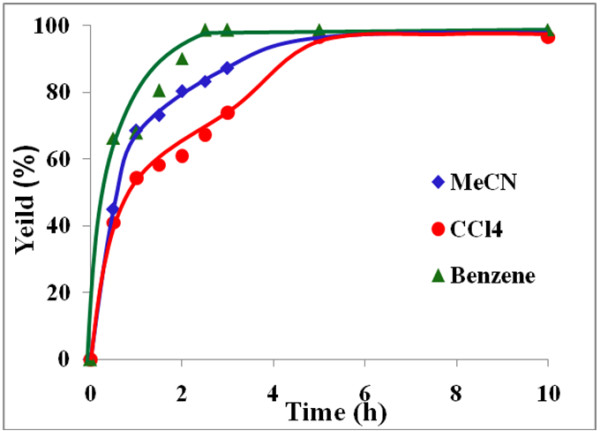
Effect of solvent on % yield of benzil using VOL1 at 50°C.